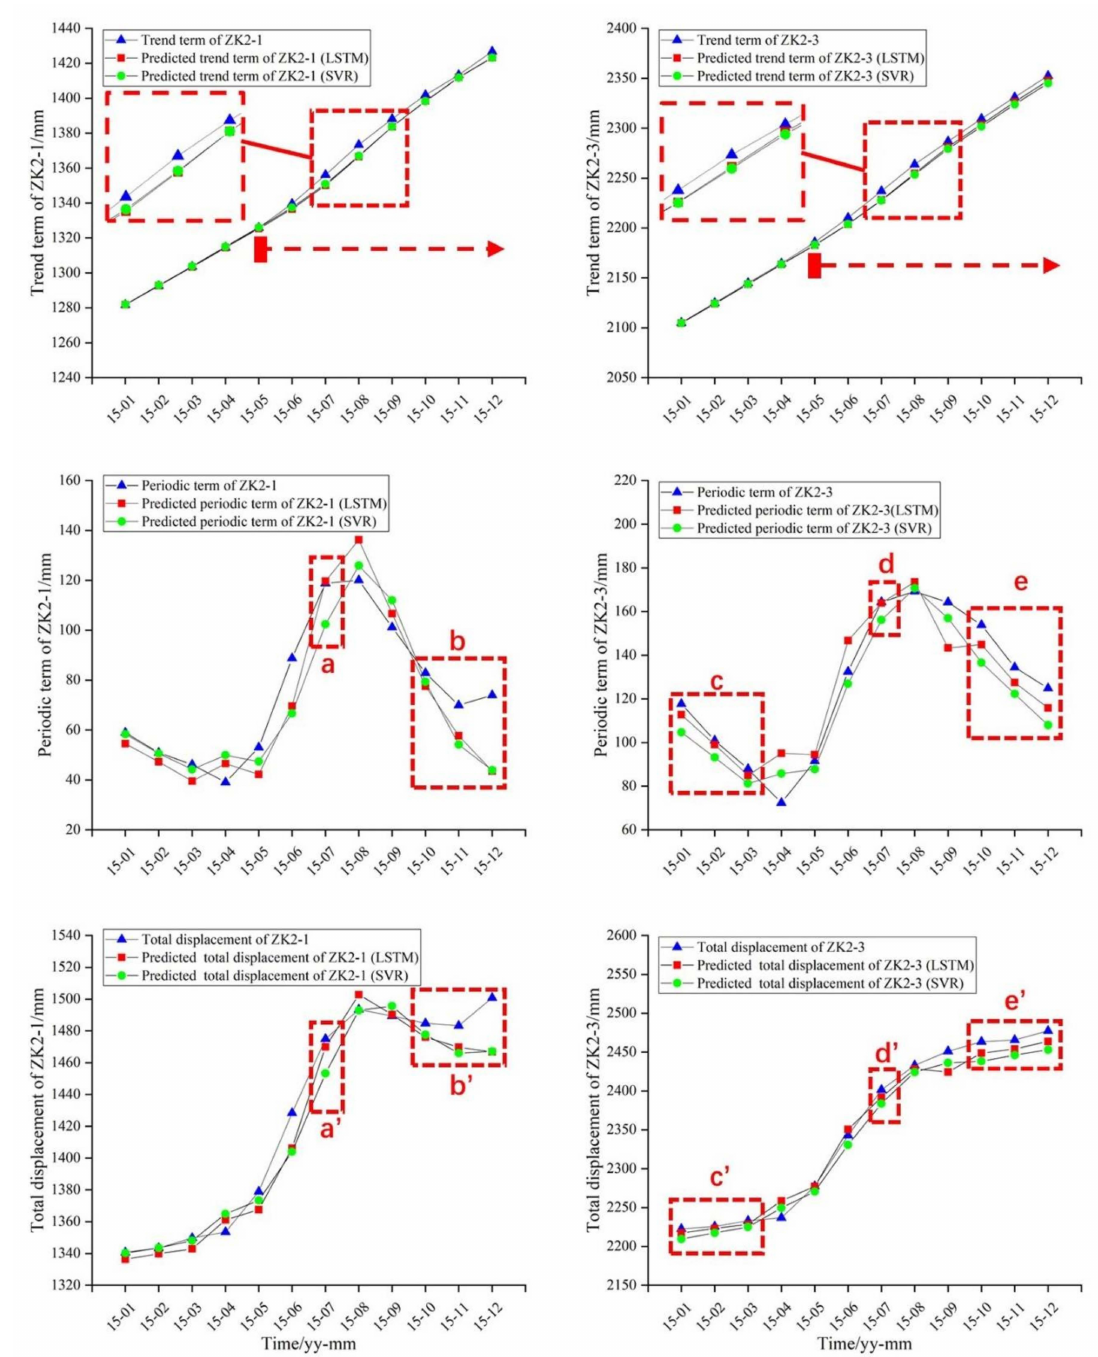
Figure 12. The curves of the relationship between observed and predicted displacement. In trend terms, the values of RMSE with the LSTM model and SVR model in ZK2-1 were 3.38 and 3.17 mm, and the values of RMSE with LSTM model and SVR model in ZK2-3were 5.23 and 6.26 mm. In periodic terms, the values of RMSE with the LSTM model and SVR model in ZK2-1 were 12.95 and 13.63 mm, and the values of RMSE with the LSTM model and SVR model in ZK2-3 were 10.92 and 10.62 mm (Table